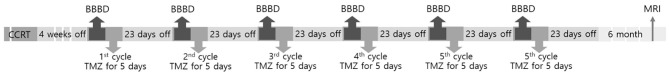
Overview of the study. CCRT, concurrent chemoradiation therapy; BBBD, blood–brain barrier disruption; TMZ, temozolomide; MRI, magnetic resonance imaging.